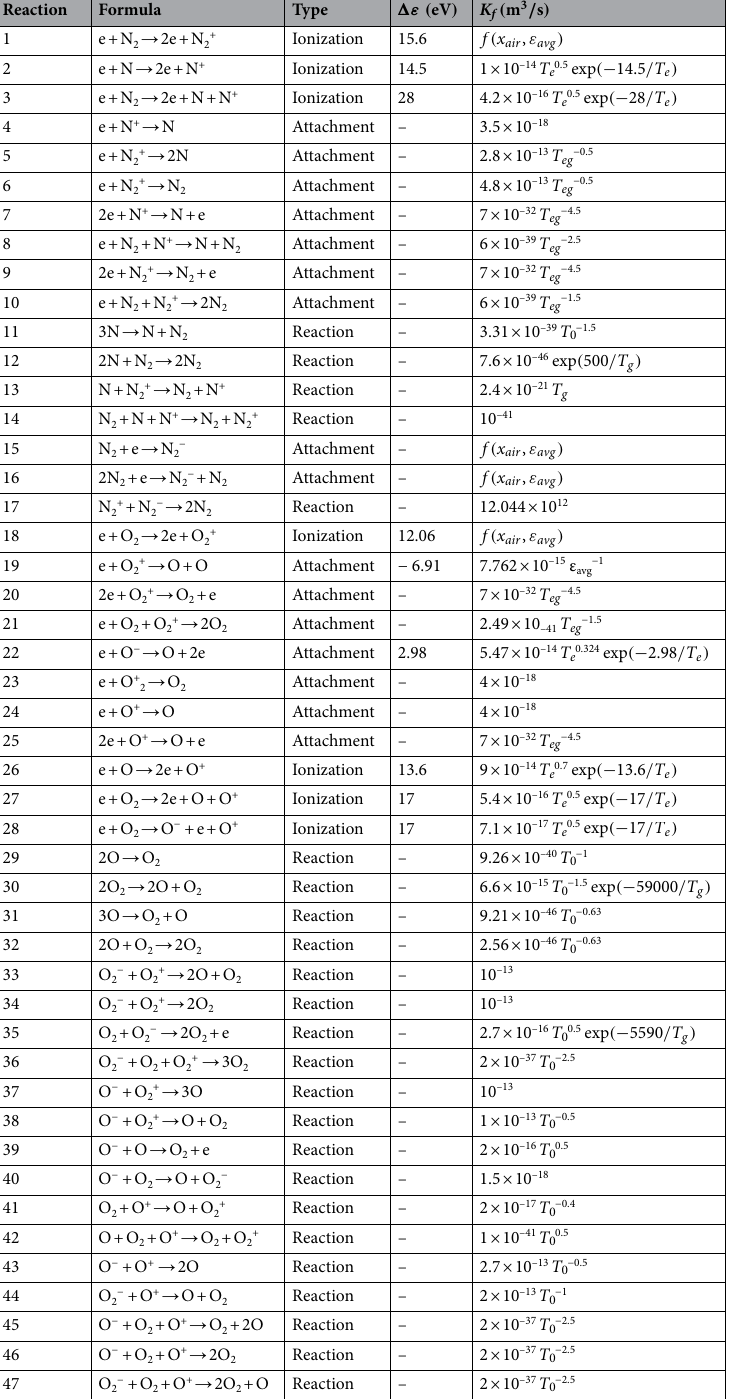
Table 1. List of Oxygen and Nitrogen chemical